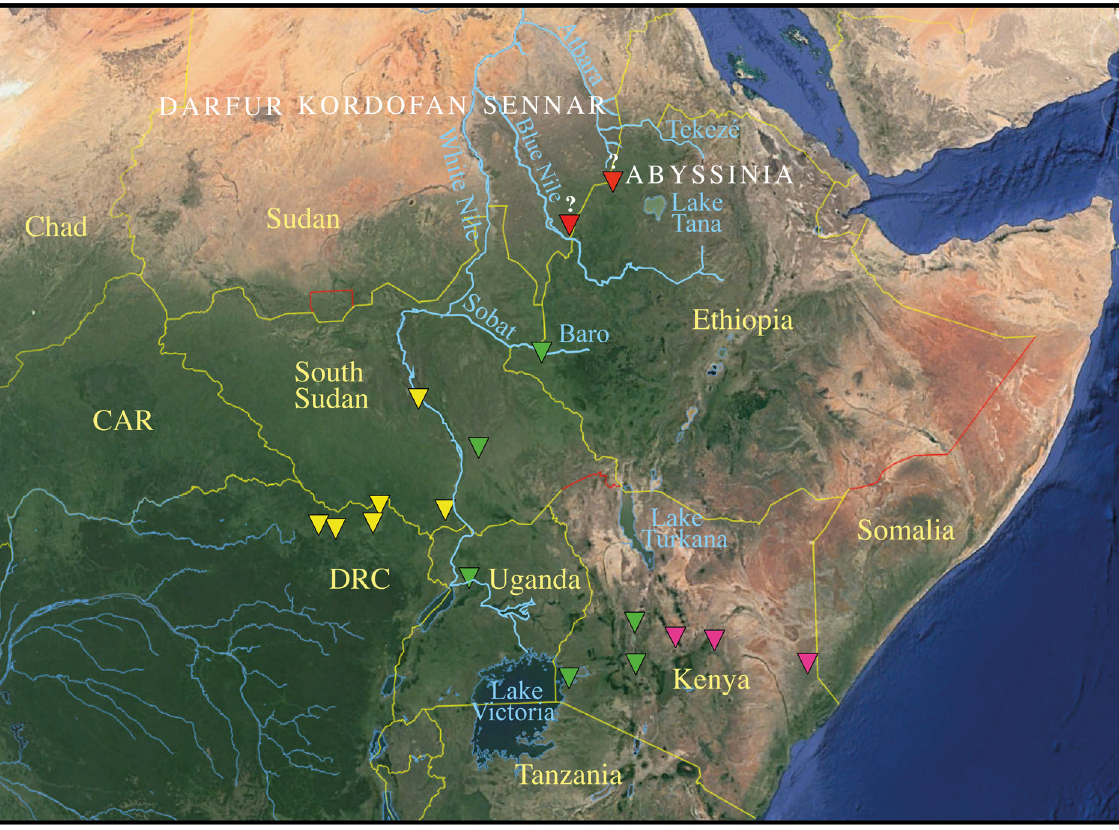
Fig. 5. Giraffe subspecies of the Nile region. The map (extracted from Google Earth; https://www.google.com/intl/de/earth/) shows the geographical barriers (rivers and mountains) that may have isolated (at least temporarily) the subspecies Giraffa camelopardalis camelopardalis (Linnaeus, 1758) (red), G. c. antiquorum (Jardine, 1835) (yellow), G. c. rothschildi Lydekker, 1903 (green) and G. c. reticulata de Winton, 1899 (magenta). The question mark refers to the uncertain geographic origin of Zarafa (left) and the two specimens from Abyssinia (right) (see Discussion for more